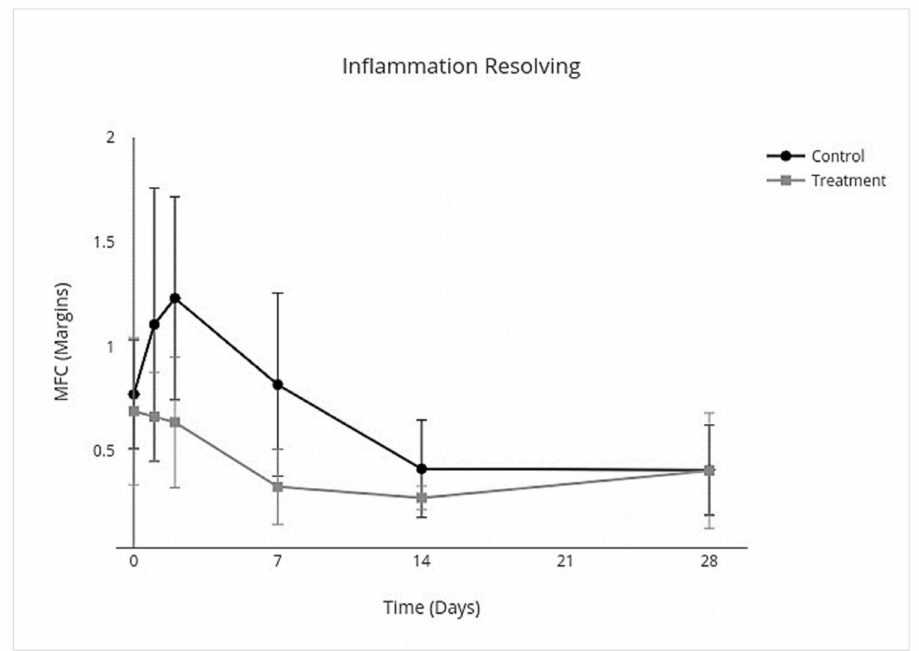
Figure 9. MFC of mRNA expression of inflammation resolving cytokines over time following IV allo-CB-MSC therapy. In the treatment group, there was an overall treatment effect over all days, characterized by decreased expression of inflammation resolving cytokines with no significant treatment effect on individual days.